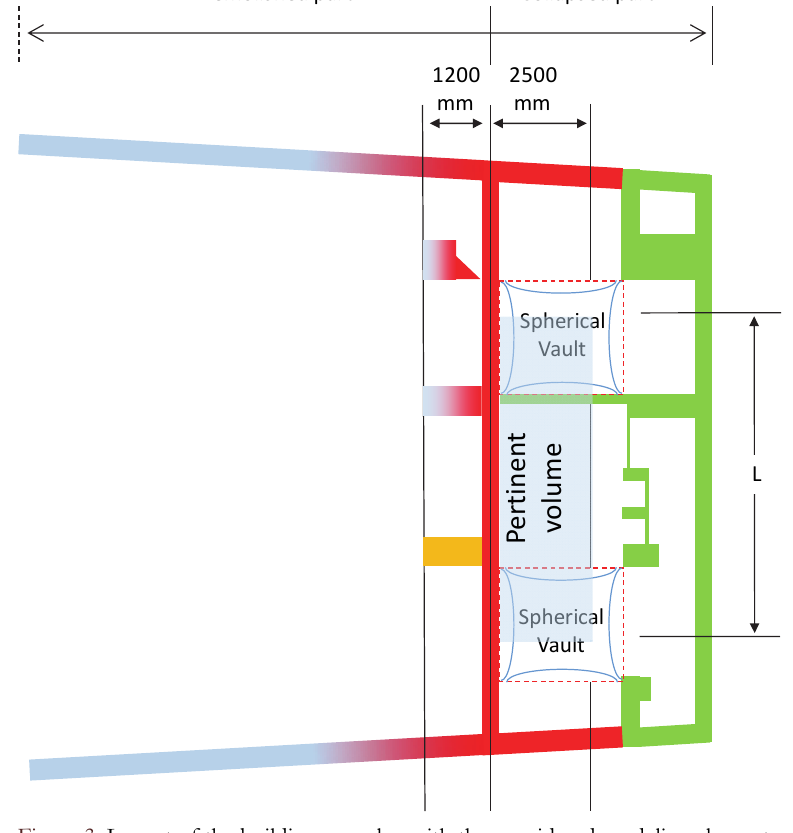
Figure 3: Layout of the building complex with the considered modeling